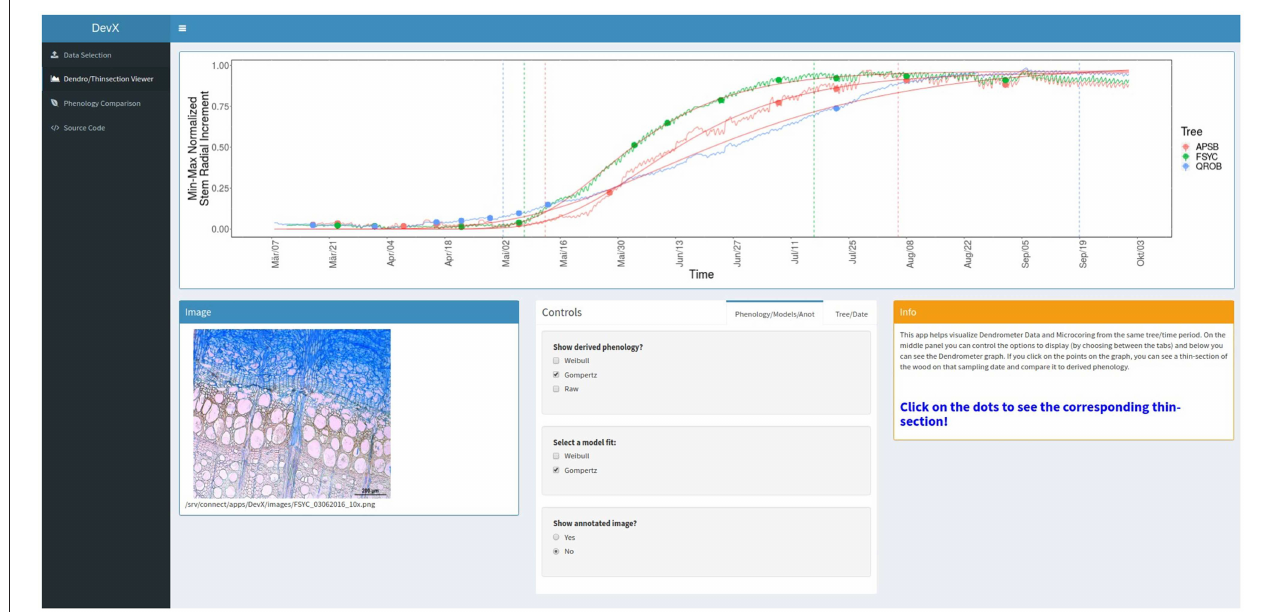
FIGURE 6 | DevX overview. A screen shot of the currently deployed online version of the presented visualization tool. An overview of its functionality and options are given in the section “Material and Methods—Interactive data